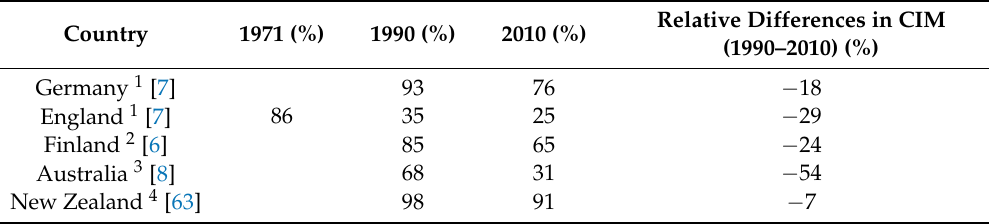
Relative Differences in CIM (1990–2010) (%)